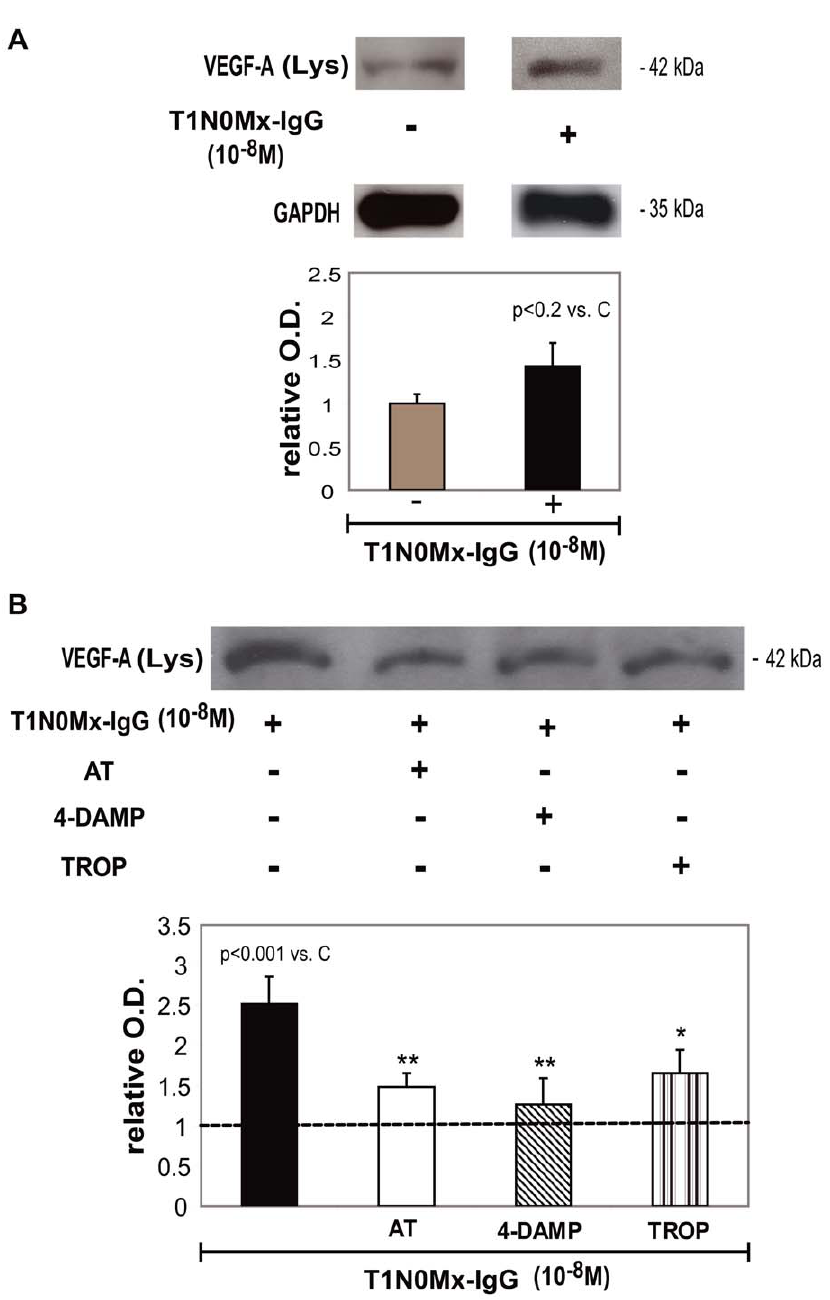
Figure 2. Effect of T1N0Mx-IgG on VEGF-A expression in MCF-7 cells. Western blot assays were performed in cell lysates (Lys) obtained from A) untreated MCF-7 cells or treated with IgG from breast cancer patients in stage I (T1N0Mx-IgG) (10 2 8 M) during 1 h in the absence or B) presence of 10 2 8 M atropine (AT) 4-diphenylacetoxi-N-methylpiperidine (4-DAMP), or tropicamide (TROP). Densitometric analysis of the bands is shown. Values were relativized to the expression of glyceraldehyde-3-phosphate dehydrogenase (GAPDH) and to the expression of VEGF-A in MCF-7 cells without treatment considered as 1, and is represented by a dotted line. Molecular weights are indicated on the right. Values are mean 6 S.E.M. of three experiments. * p , 0.01; ** p , 0.001 vs. T1N0Mx-IgG.